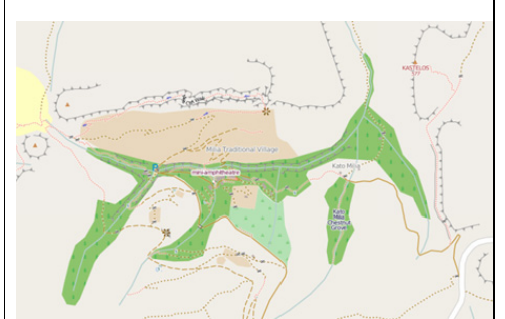
Figure 10: Archaeological sites mapped by